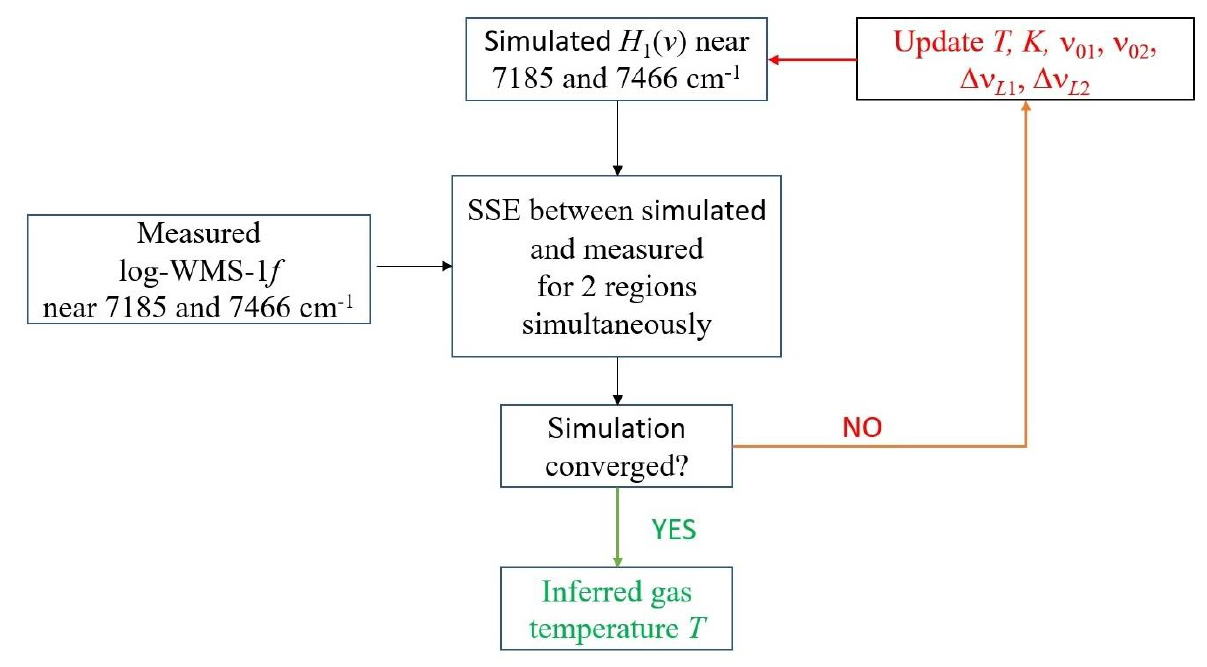
Figure 5. Flow chart for the first algorithm for inferring the temperature from the measured spectra. SSE is the sum of squared errors.